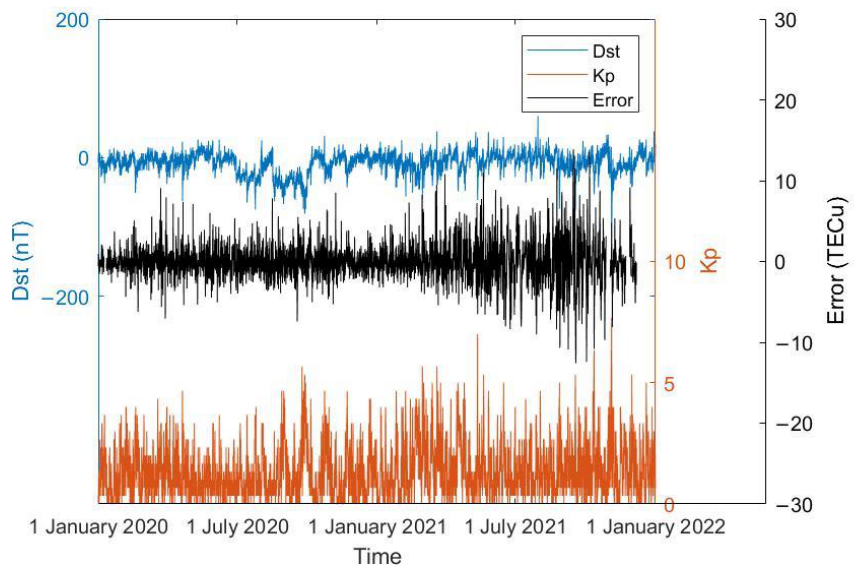
Figure 10. The deviation of observed TEC from predicted TEC.